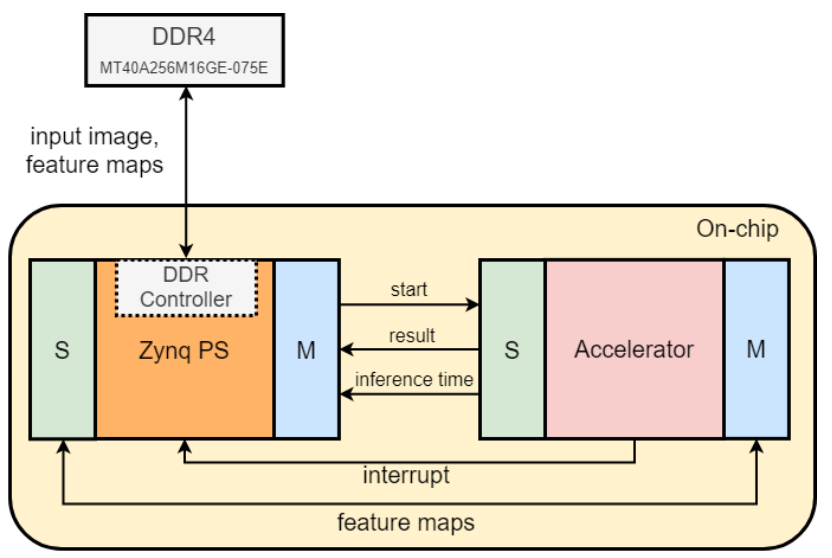
Figure 7. CloudScout characterization